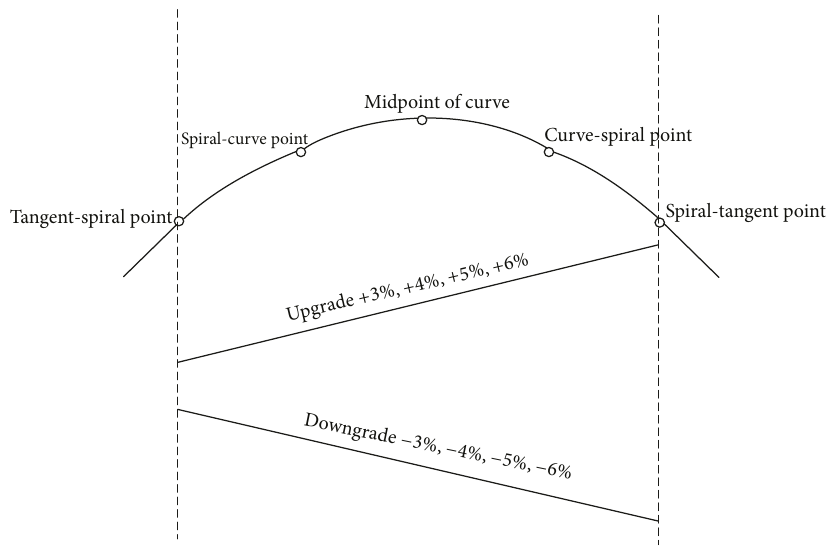
Figure 6: Road geometric parameters of